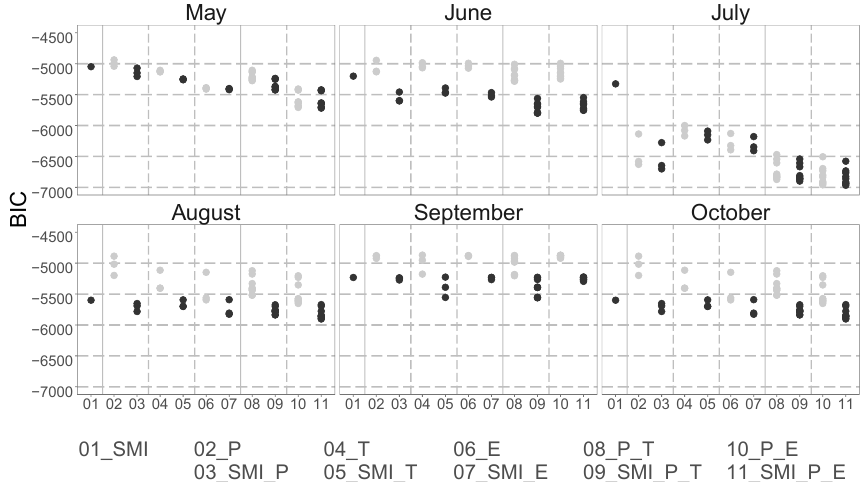
Figure 2. Each panel shows the BIC distribution of 1 month. Within the panels various models are compared, whilst the lowest marker is preferred. Each column represents a particular selection of variables. The markers represent different degrees of the polynomials in the meteorological term. The gray markers denote those models that neglect the SMI, whilst the black include